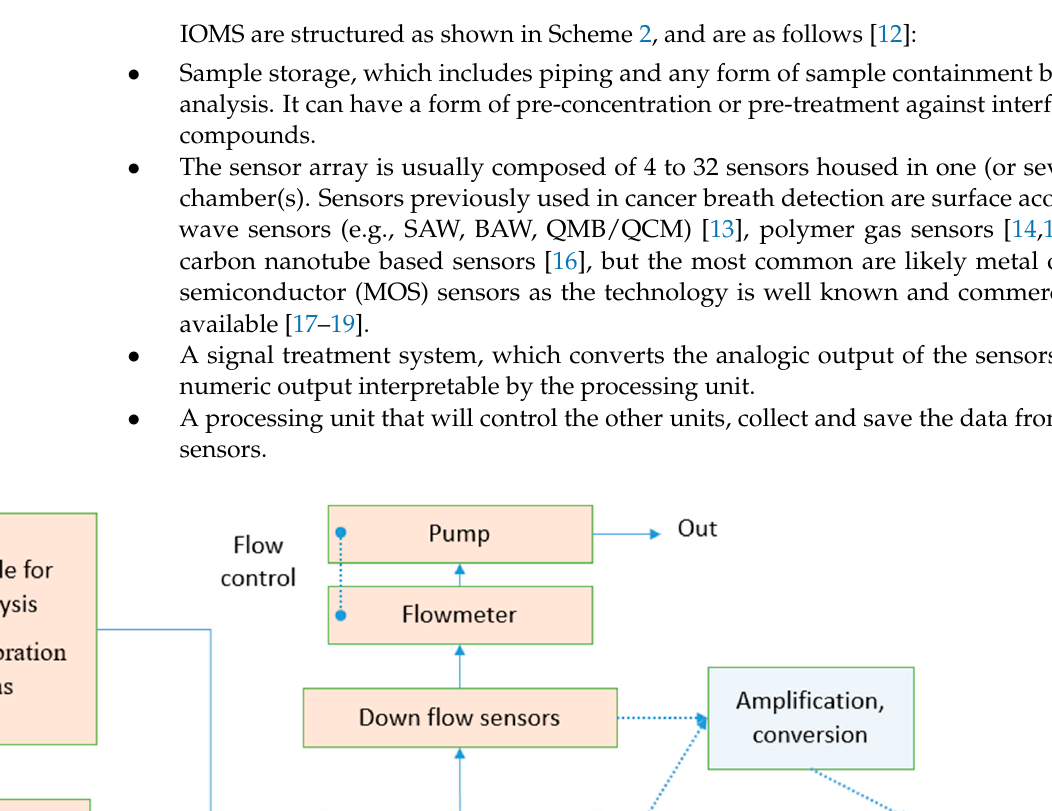
Scheme 1. Breathprint disease recognition principle using an IOMS.